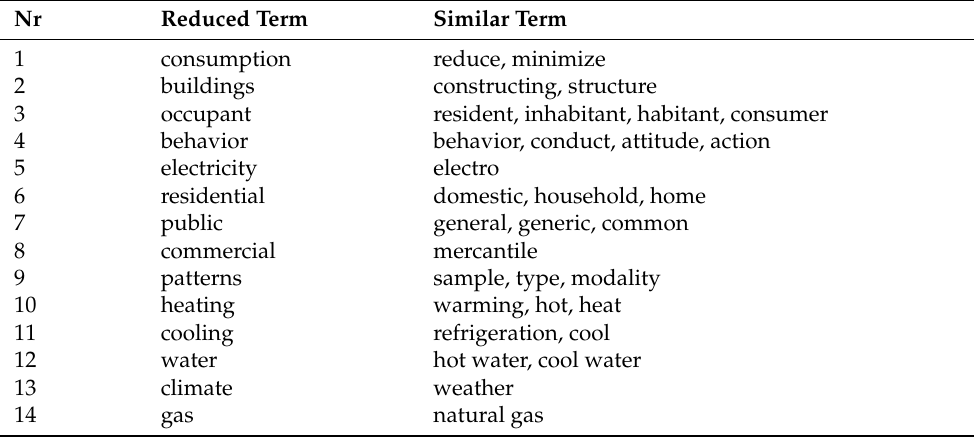
Table 5. Dictionary for the “energy” domain.